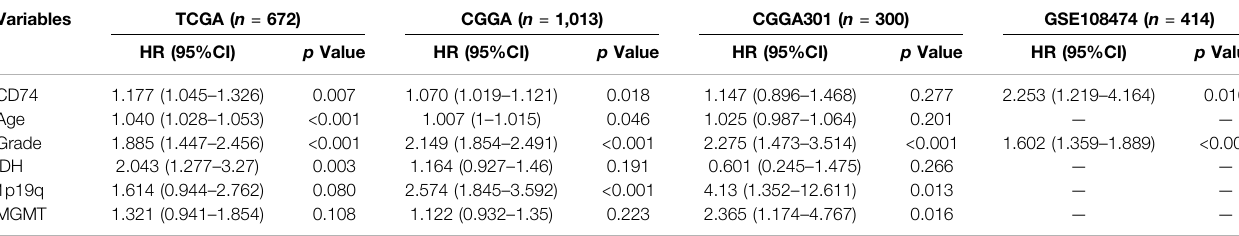
TABLE 3 | Multivariate analysis of CD74 and clinical features in four datasets.